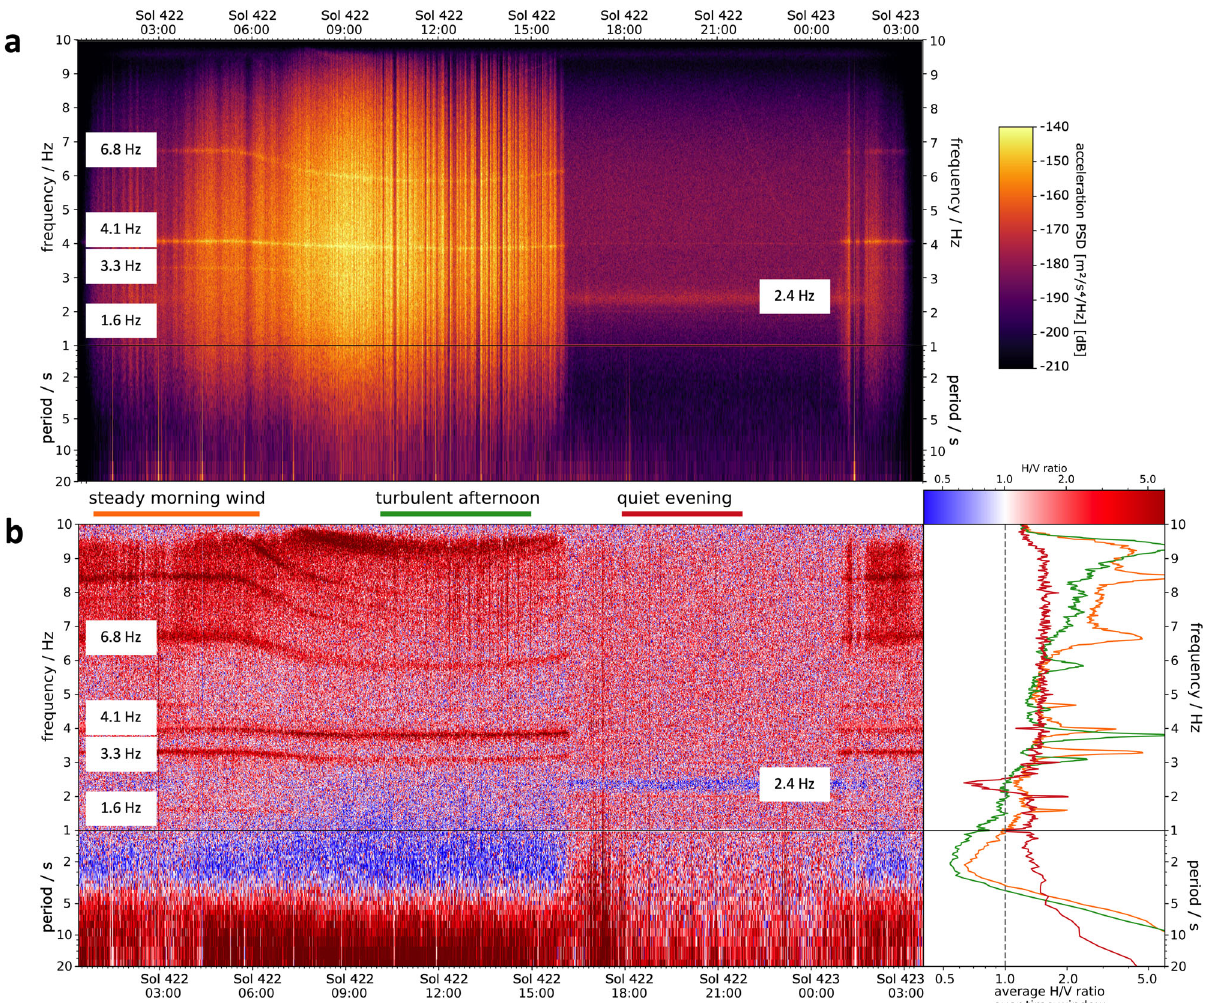
Fig. 2 Frequency-domain characteristics of sols 422 and 423 SEIS data. a Vertical-component spectrogram of sols 422 and 423. Typically, mornings and afternoons show high levels of wind-induced noise, while evenings and nights are characterized by signi fi cantly lower ambient noise levels due to largely absent local winds. Note the lander-related modes (e.g., at 1.6, 3.3, 4.1, 6.8 Hz) that show a time-dependent change of their resonance frequencies. The lander-related modes correlate with the wind activity, suggesting that winds shaking the lander are the cause of these resonances. b H/V ratio for the same data as in ( a ). During quiet time intervals such as in the evening hours, the ambient vibration power spectrum is relatively fl at with the prominent exception of a distinct H/V trough at around 2.4 Hz. (right) Three H/V curves extracted for two windy and one quiet period of sols 422/423. The orange curve corresponds to the steady morning wind time window, the green curve to the turbulent afternoon time window and the red curve to the quiet evening time window (see colored bars marking the time